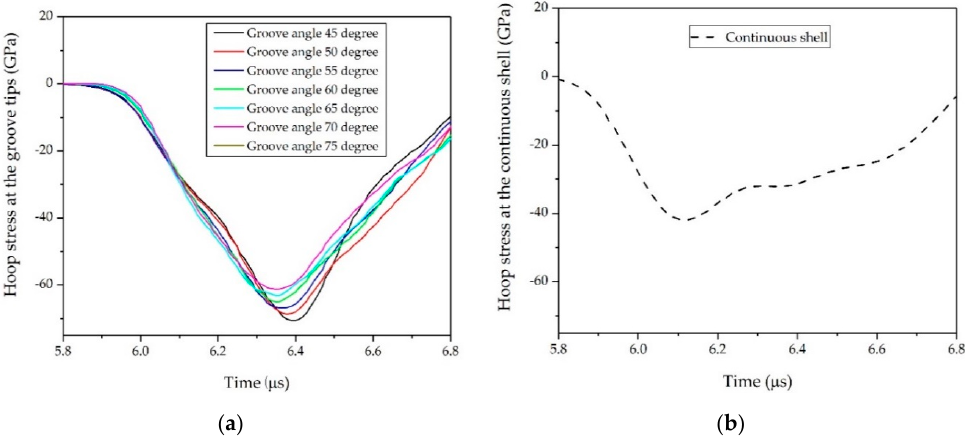
Figure 9. Hoop stress at groove tips and the stress at the same position inside the continuous shell (NO. 1): ( a ) relationship between groove angle θ and hoop stress at groove tips and ( b ) relationship between groove angle θ and the stress at same position inside the continuous shell.